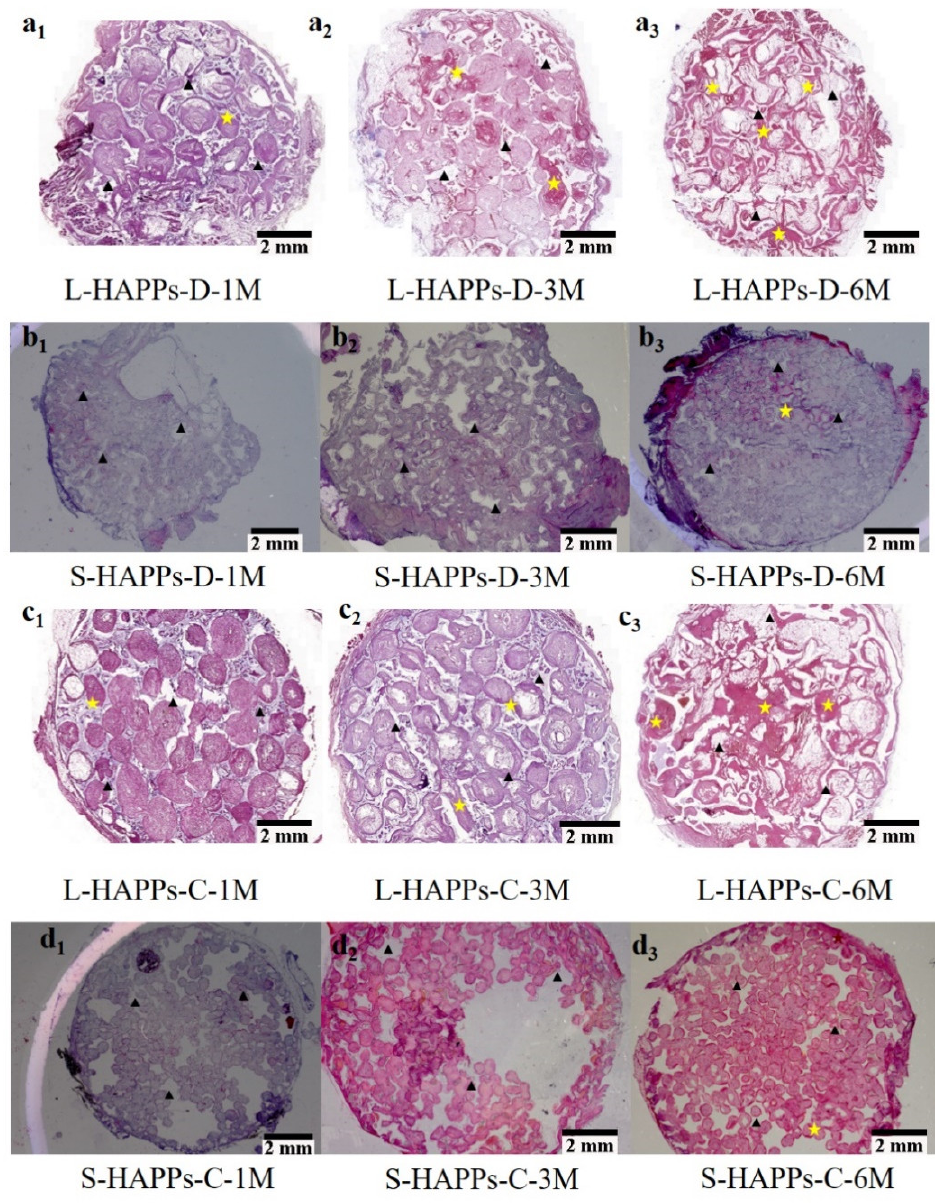
Figure 3. Relationship between the ectopic bone formations of HAPPs and the macropore sizes implanted in dorsal muscle/abdominal cavity by H&E staining. ( a 1 – a 3 ) L-HAPPs implanted 1, 3 and 6 months, ( b 1 – b 3 ) S-HASAs implanted 1, 3 and 6 months, ( c 1 – c 3 ) L-HAPPs implanted 1, 3 and 6 months, ( d 1 – d 3 ) S-HASAs implanted 1, 3 and 6 months. With the implantation time extended, new bone tissues were found in all scaffolds, which was better in the L-HAPPs than those in the S-HAPPs. Black triangles show HA materials, yellow stars show new bone. The bar = 2 mm. One month after implantation, new bone formation was only observed in the L-HAPPs, both in the dorsal muscle (4.27 ± 1.85%) and in the abdominal cavity (3.06 ± 0.94%). Six months after implantation, the ratio of new bone formation in the L-HAPPs was 28.31 ± 3.06% in the dorsal muscle and 15.93 ± 3.87% in the abdominal cavity. In com- parison, for the L-HASAs, new bone formation was 22.27 ± 2.89% in the dorsal mus- cle and 10.28 ± 2.06% in the abdominal cavity (Figure 4a,b). For the S-HAPPs, it